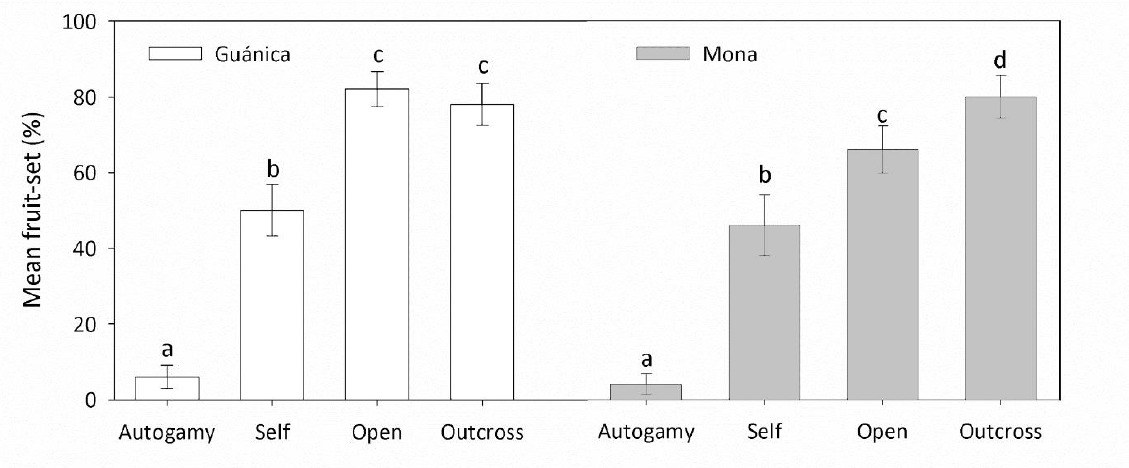
Figure 4. Mean fruit-set for different pollination treatments for each island. Error bars are standard error of the mean. Different letters above the columns indicate significant differences (Tukey’s post hoc tests, P < 0.05) among pollination